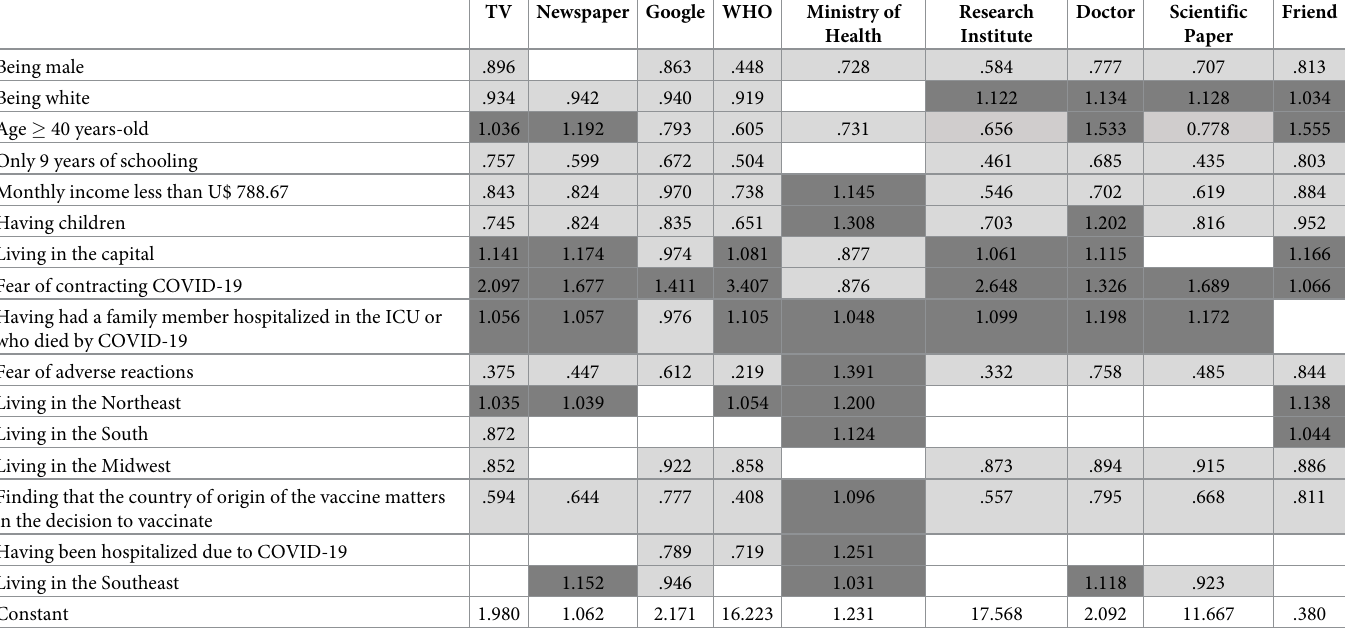
Table 1. Multivariate logistic regression to assess factors associated with trust in the information source.